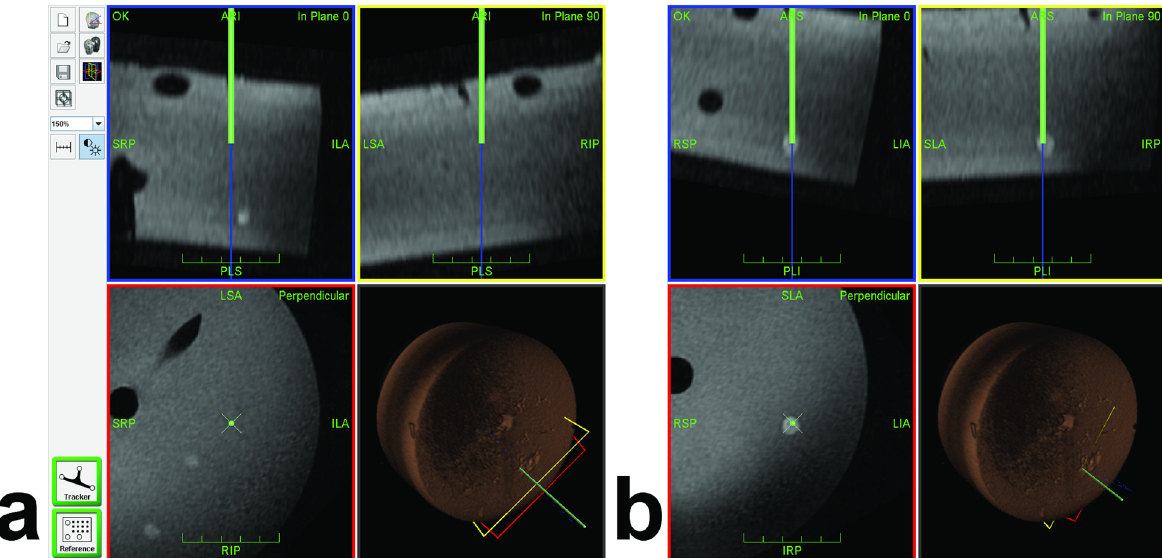
Fig 3. Navigation Interface During Target Approach. The navigation interface continuously displays three orthogonal planes reconstructed from the planning MRI dataset along (in-plane 0° and in-plane 90°, blue and yellow frames) and perpendicular (red frame) to the tracked needle. The virtual needle and its extension are displayed as green and blue lines, respectively (virtual tip at the end of the green line). The fourth view indicates the 3D position of the needle and all viewing planes with respect to the volume-rendered MRI dataset. Phantom vessels (tubes) and targets (peas) appear as hypointense and hyperintense structures, respectively. (a) Sample screenshot of a partially inserted needle with the virtual extension slightly off target (#10, in plane 0°). Two other targets (#6 and #7) happen to appear in the perpendicular view. (b) Later screenshot after corresponding adjustment showing the virtual needle tip inside the target (in all views).